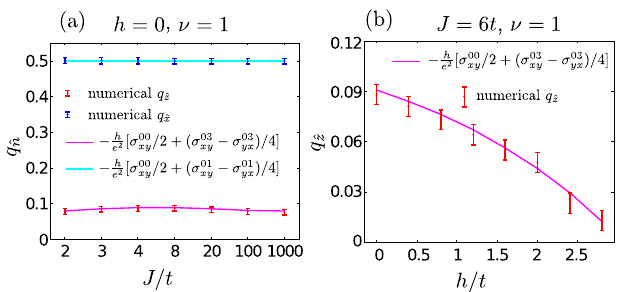
FIG. 9. (a) Vortex charge for the kagome´ lattice for different coupling strengths in the absence of a magnetic field. Red (blue) dots were obtained by exact diagonalization for a vortex with rotations around the ^ z ( ^ x ) axis. The solid lines are the analytical predictions from the Laughlin argument. As stated in the main text, the kagome´ lattice has a net magnetization (in the z direction), and stable vortices must have an axis of rotation pinned to the z axis. Despite agreement with the Laughlin argument, the charge of the vortex with the ^ x axis is not stable and will change with the relaxation of the vortex. (b) Zeeman- field dependence of the vortex charge for the kagome´ lattice. Red dots were obtained by exact diagonalization. The solid line is the result expected from Laughlin’s adiabatic argument. The elec- tronic filling is 5 = 6 in both